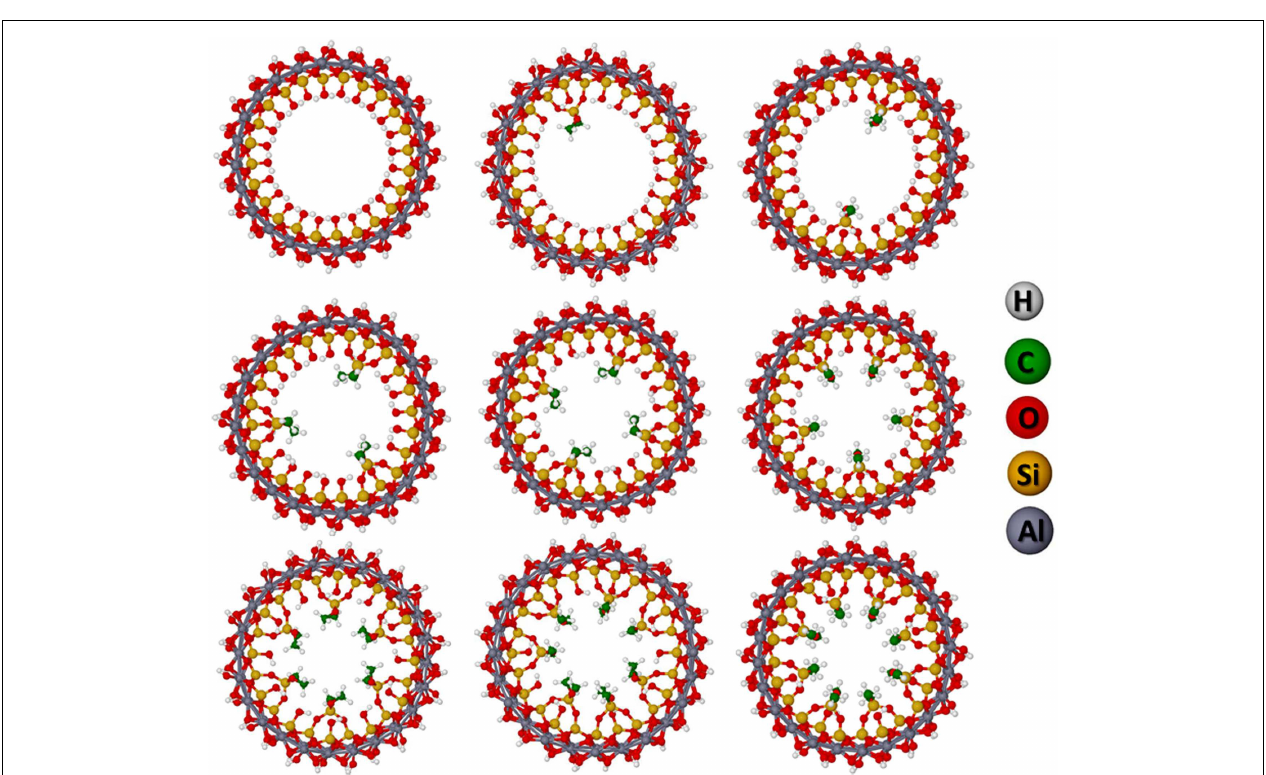
FIGURE 5 |The optimized structures of the substituted (12,0) imogolite .